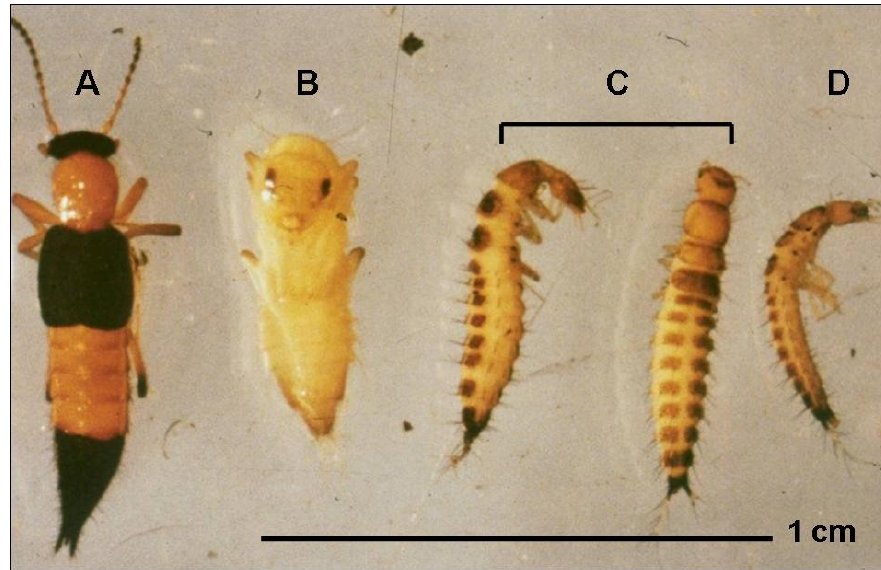
Figure 7. Adult ( A ), pupa ( B ), second instar ( C ) and first larval instar ( D ) of Paederus fuscipes (Caspian Sea